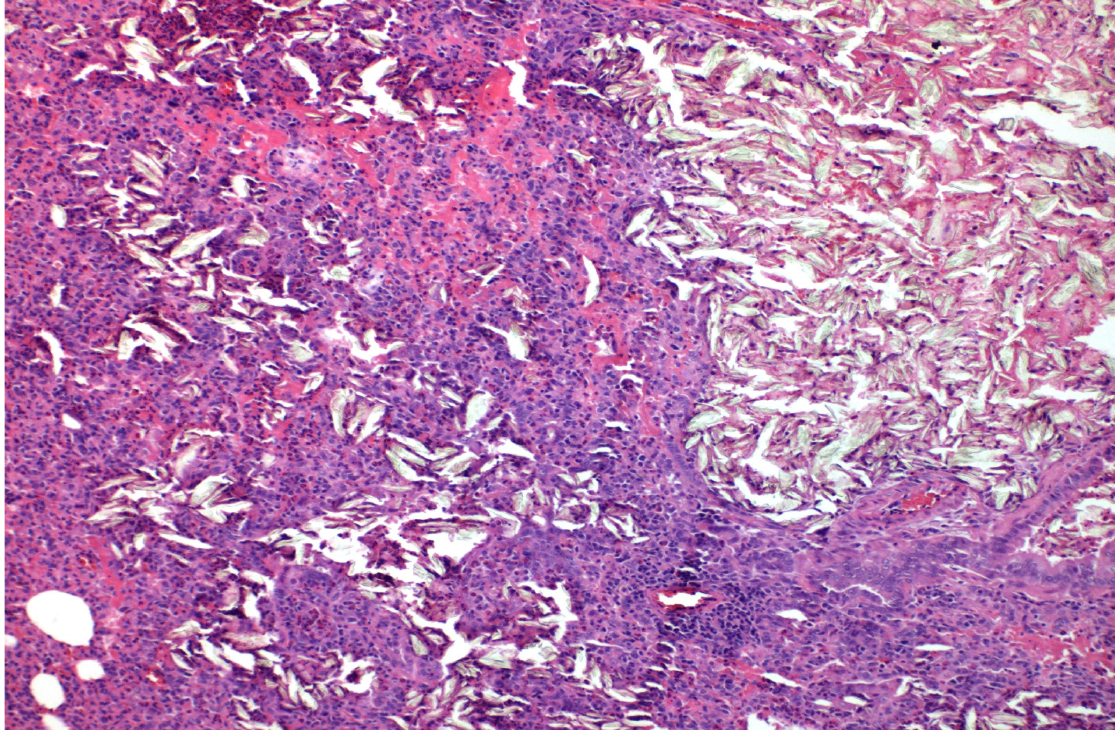
Figure 1. ×100 Hematoxylin-Eosin stain. Foreign Body Crystal Aggregations after talc installation and Pulmonary Parenchymal Thickening.